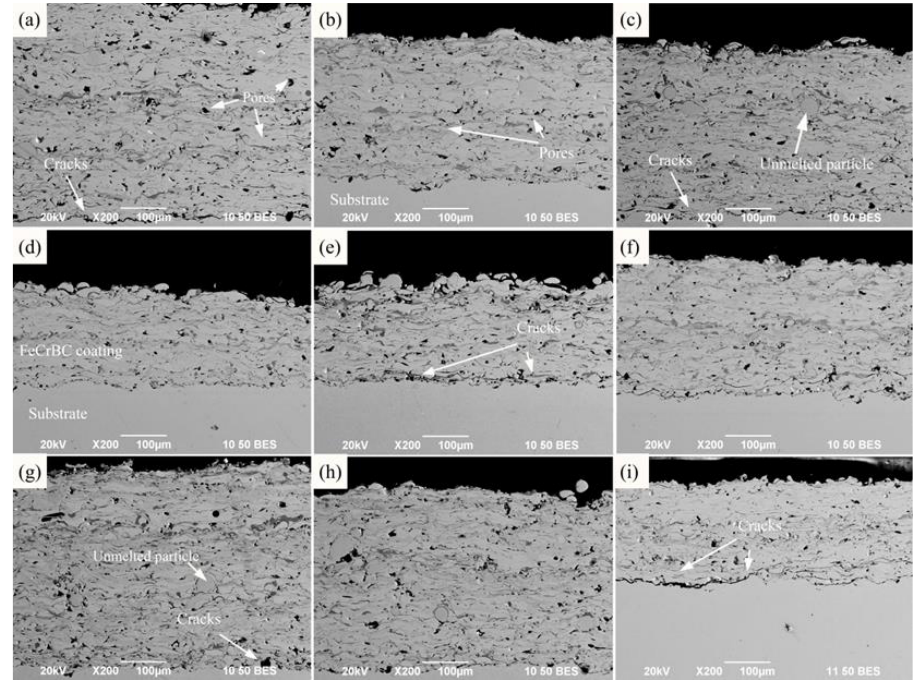
Figure 6. Cross-sectional SEM images of the Fe-Cr-B-C coating with different spray parameters levels ( a ) is a, ( b ) is b, ( c ) is c, ( d ) is d, ( e ) is e, ( f ) is f, ( g ) is g, ( h ) is h and ( i ) is i as listed in Table 1.